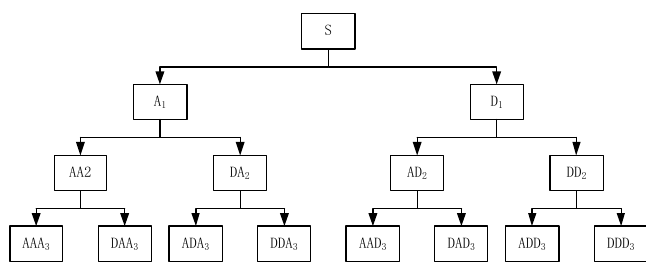
Figure 2. Wavelet packet decomposition.